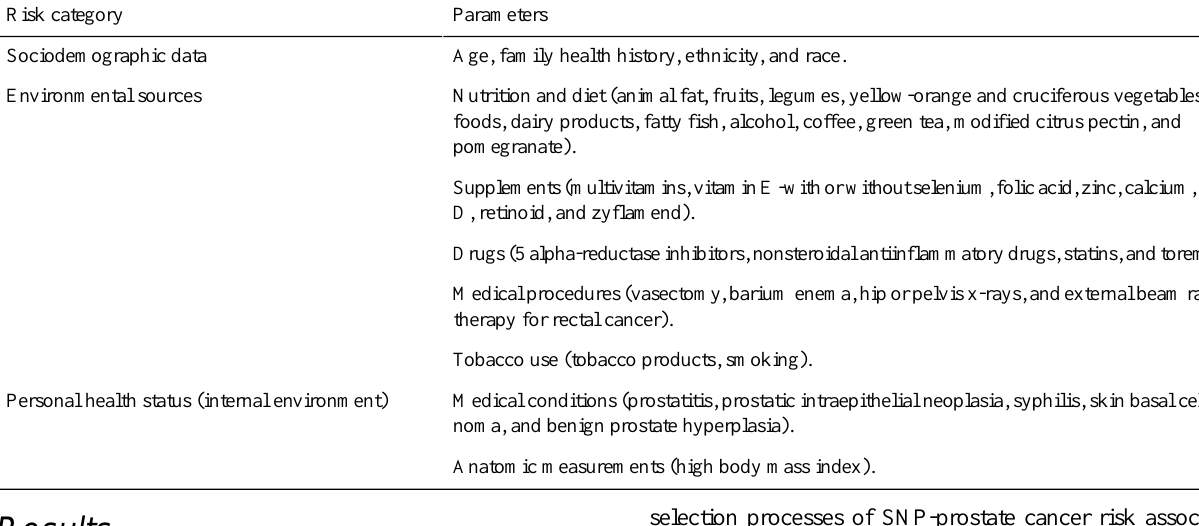
Table 4. Example list of several risk and protective factors for the prostate cancer [2,3]. ParametersRisk category